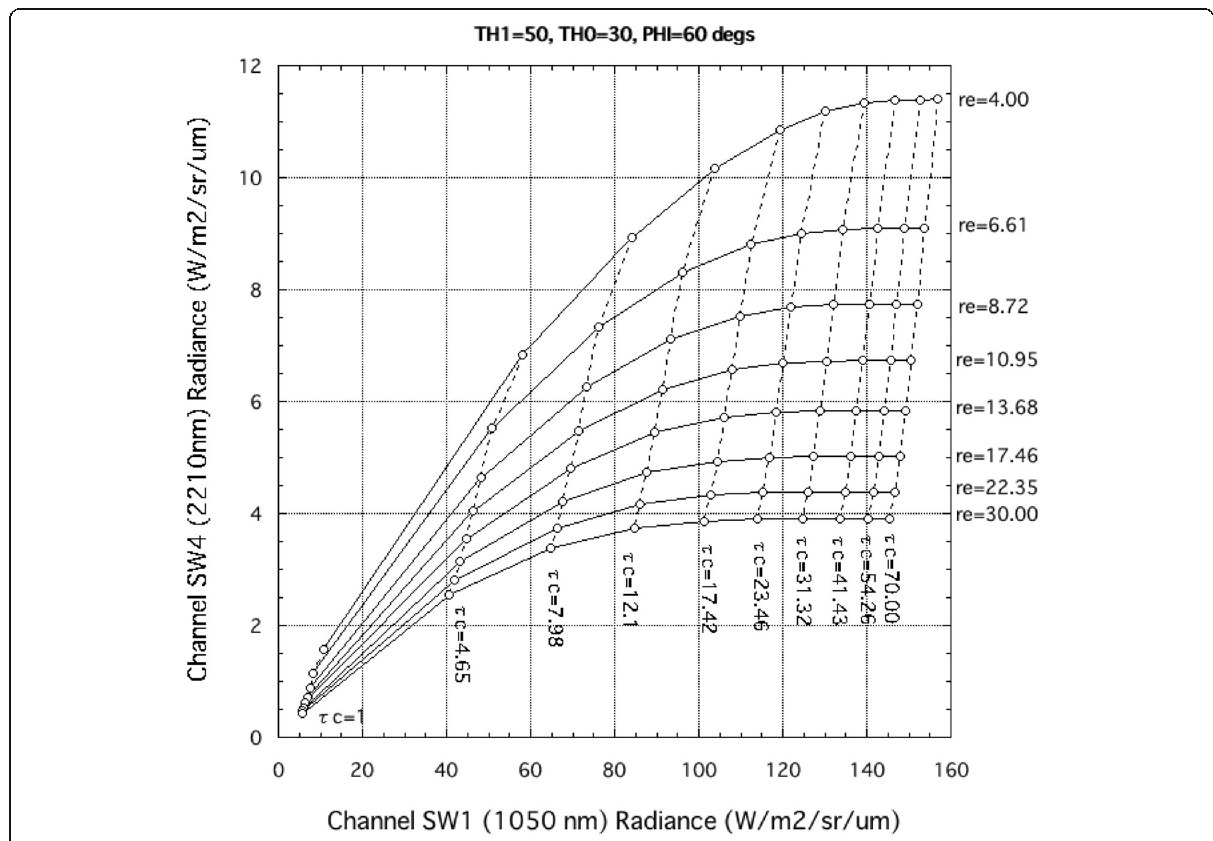
Fig. 7 Nakajima-King diagram of the SGLI for SW1 versus SW4. Warm water clouds are assumed. The satellite zenith angle (TH1), solar zenith angle (TH0), and relative azimuthal angle (PHI) are 50°, 30°, and 60°,